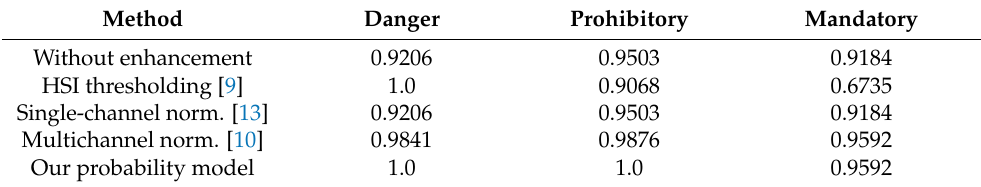
Table 2. Detection accuracy (20) of Selective Search on GTSDB data.